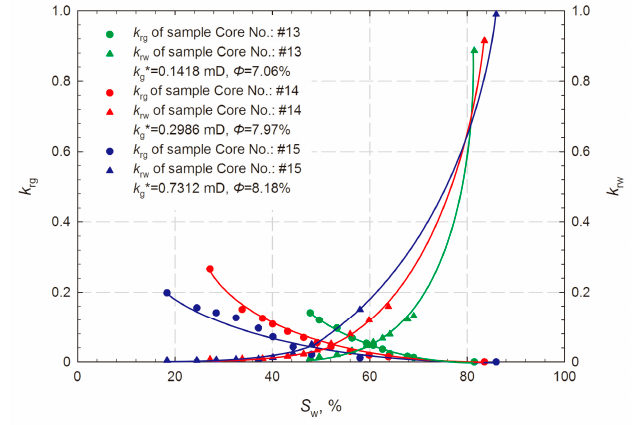
Figure 7. Effect of permeability on gas–water relative permeability.